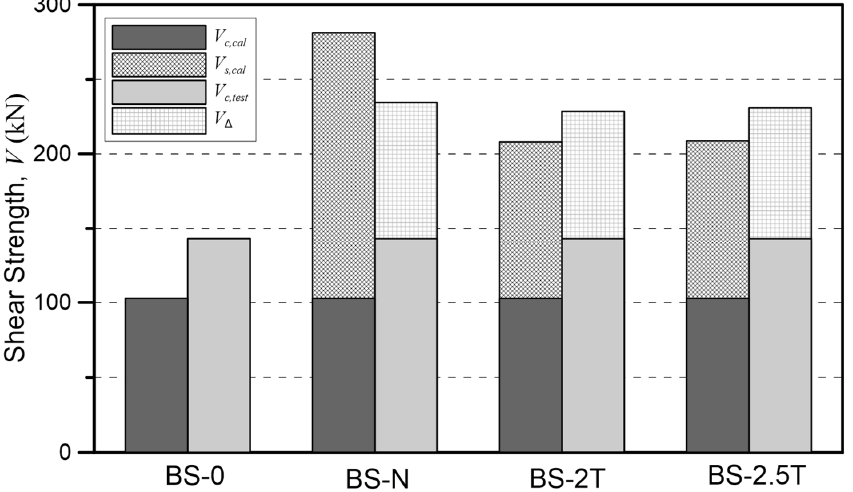
Figure 9. Comparison of shear contributions of the tested reinforcements, rebar, and steel plates.